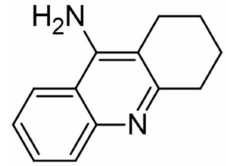
Figure 4. Chemical structure of